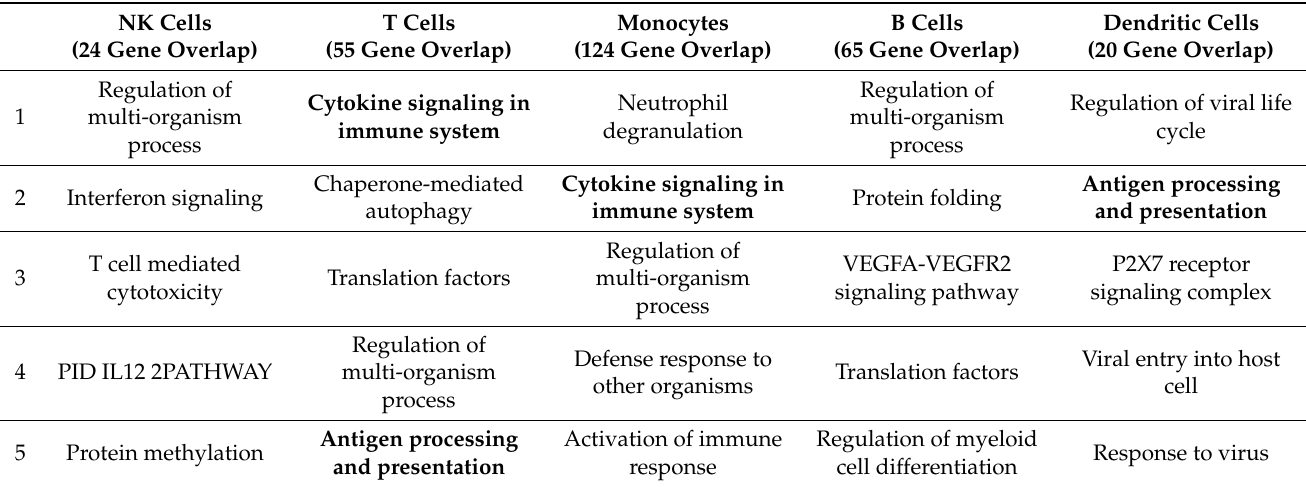
Table 3. Top ten biological functions most sensitive to chemical exposures and COVID-19 disease in immune cells. Biological functions sensitive to both xenobiotics and SARS-CoV-2 in more than one cell type are shown in bold.